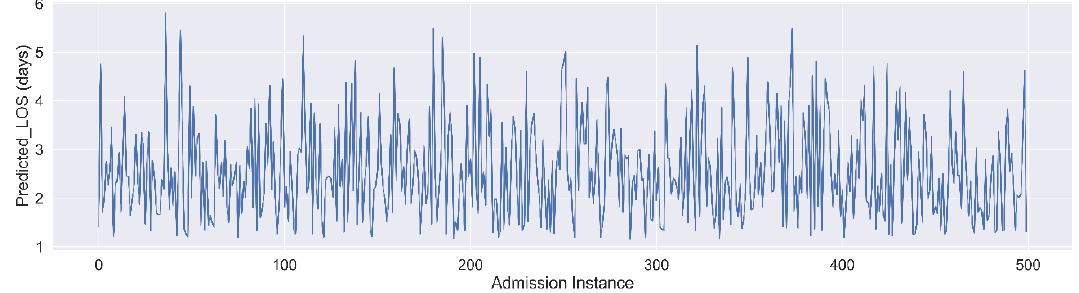
Figure 7. Predicted LOS for the first 500 admission instances in the test data.